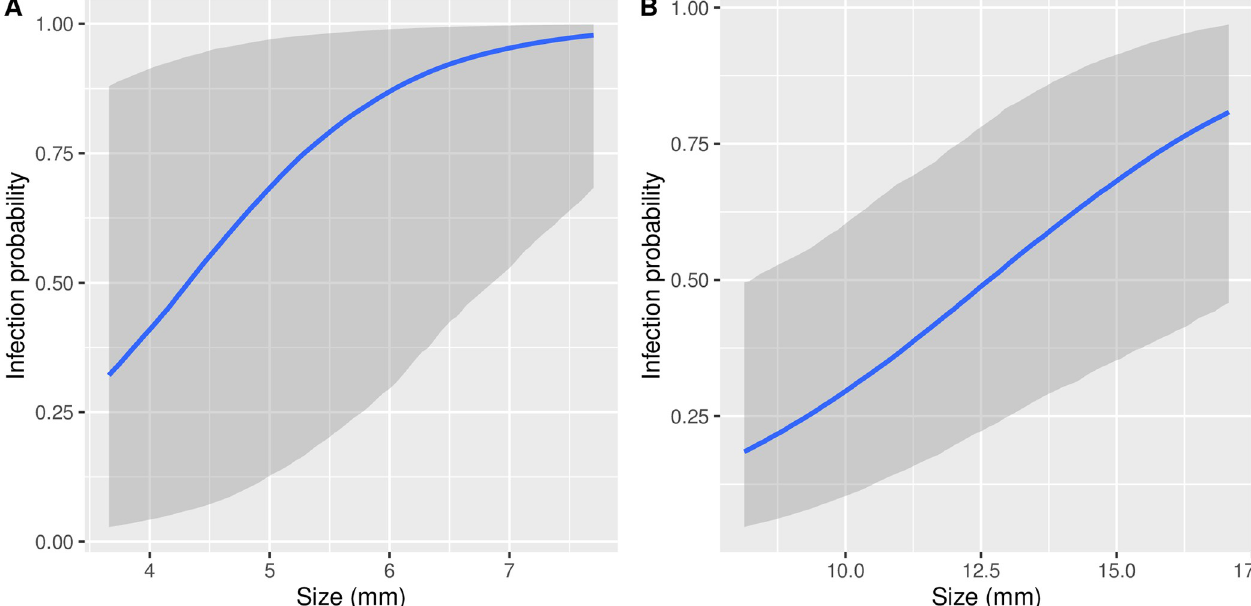
Fig 3. Native snail length and infection status. The predicted effects, with 95% credible intervals, of shell length of the native snails a) Pyrgulopsis and b) Galba on infection status, of all trematodes combined, from the models in Table 3. Infection rates were higher in Pyrgulopsis and increased more steeply with shell length until most Pyrgulopsis > 6 mm were infected by trematodes.